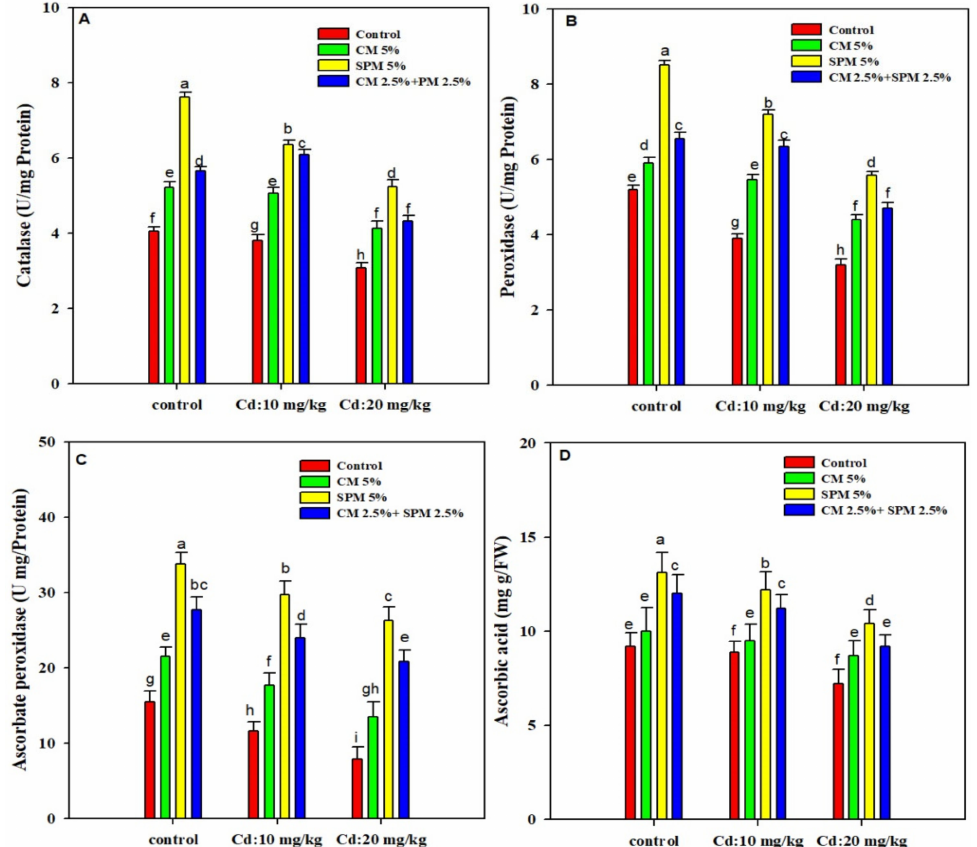
Figure 2. Effect of organic amendments on root fresh weight ( A ) root dry weight ( B ) shoot fresh weight ( C ) and shoot dry weight ( D ) of mash beans plants subjected to different levels of Cd stress (0, 10 and 20 mg/kg). The vertical bars in each figure are the mean of three replications with ± S.E. and different letters on bars indicating the significant difference at p <